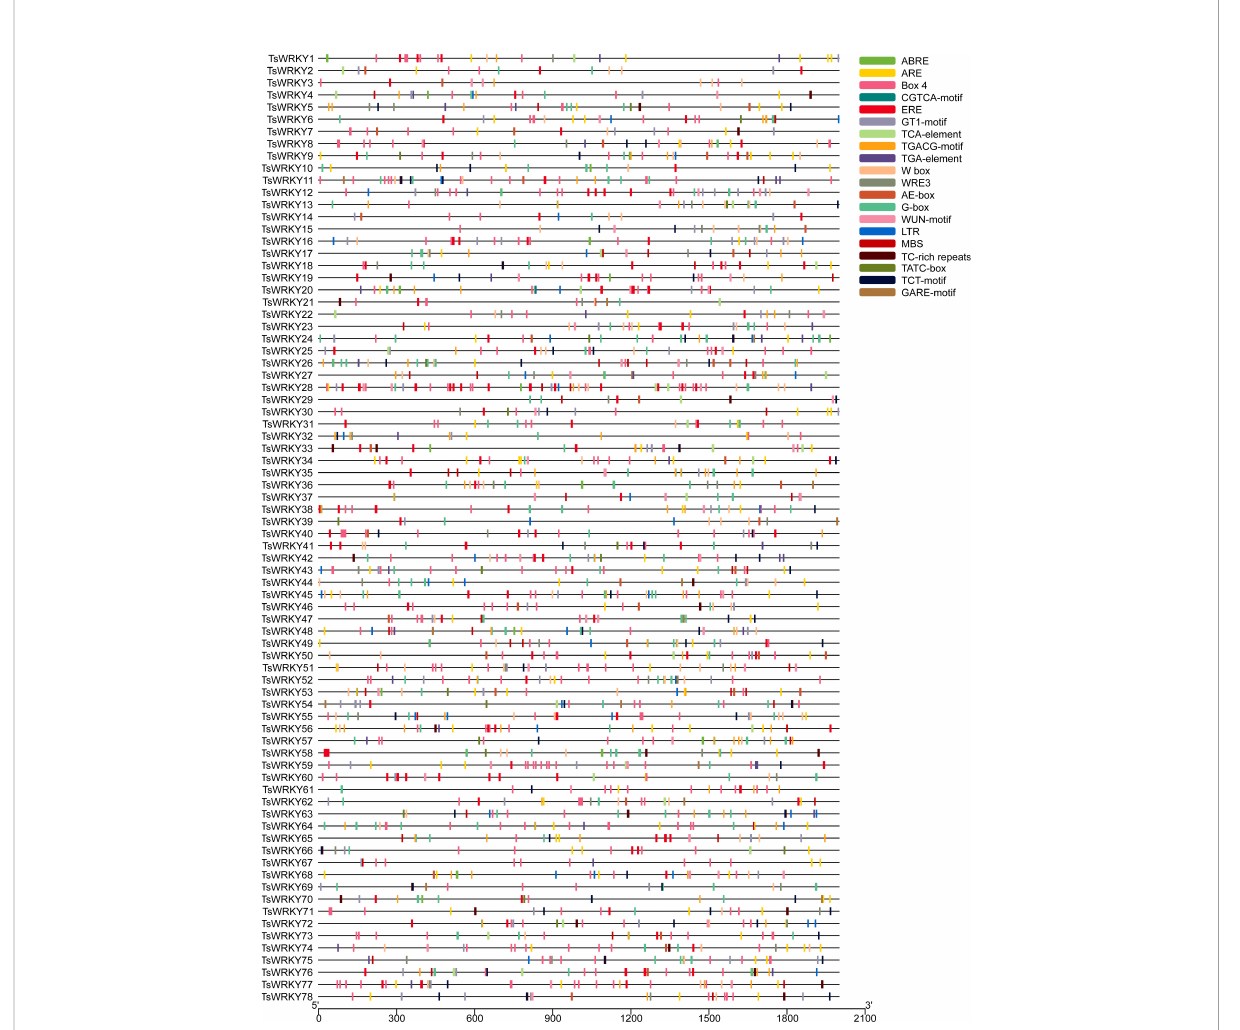
FIGURE 4 The prediction of CREs in the 2000 bp promoter upstream of the TsWRKY genes . The main CREs are showed in the upper right